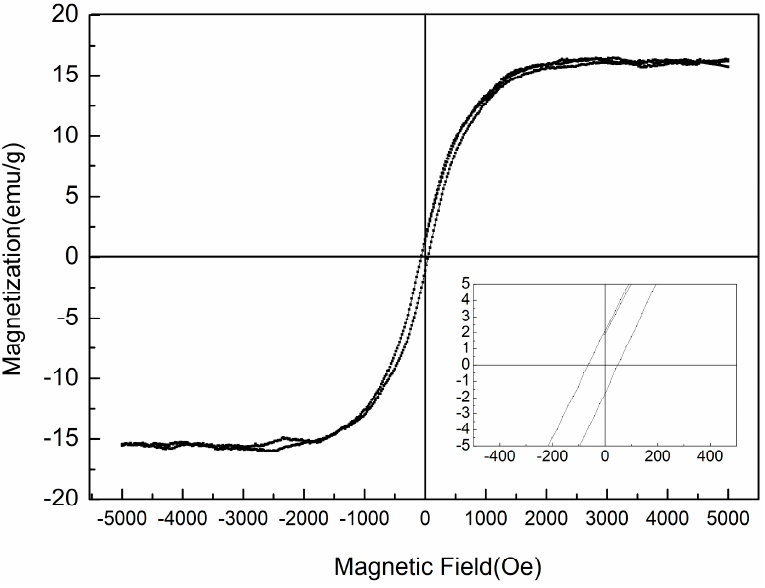
Figure 5. Magnetic hysteresis loop of a BPFMO/BGTWO bilayer thin film.